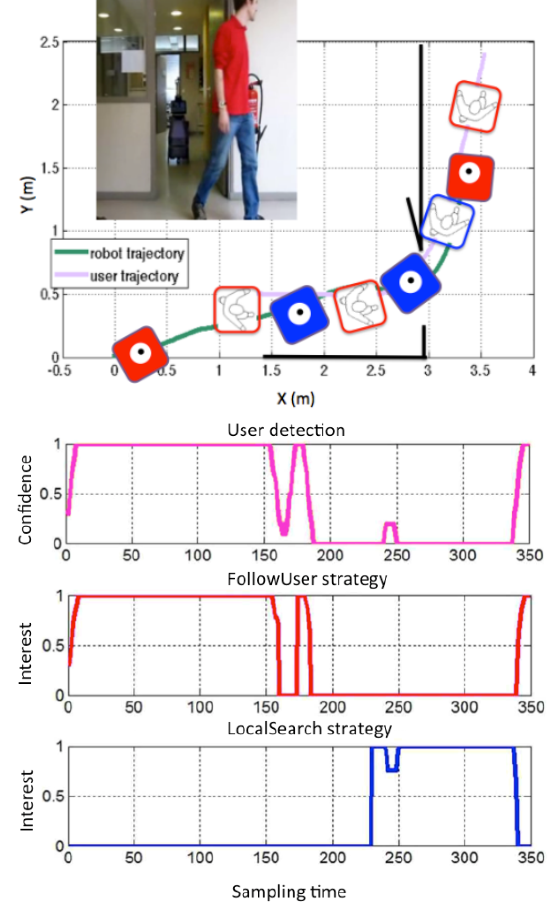
Figure 7. Top: Example of following of a person exiting through the door. Bot- tom: The robot selected strategies to remain close to the person. Colors: red when the robot detects the person, blue when it